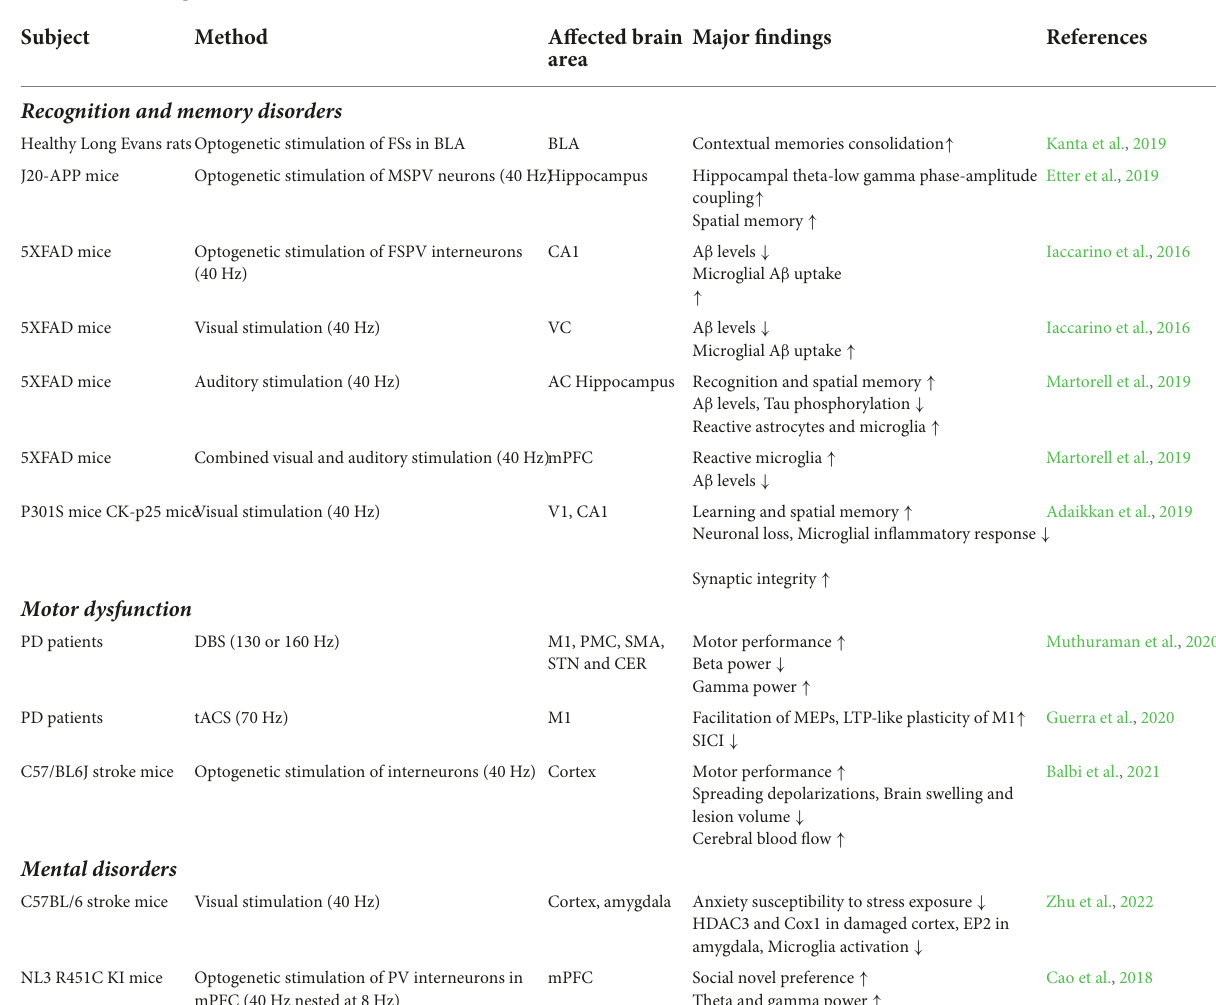
TABLE 2 Effects of gamma entrainment in CNS